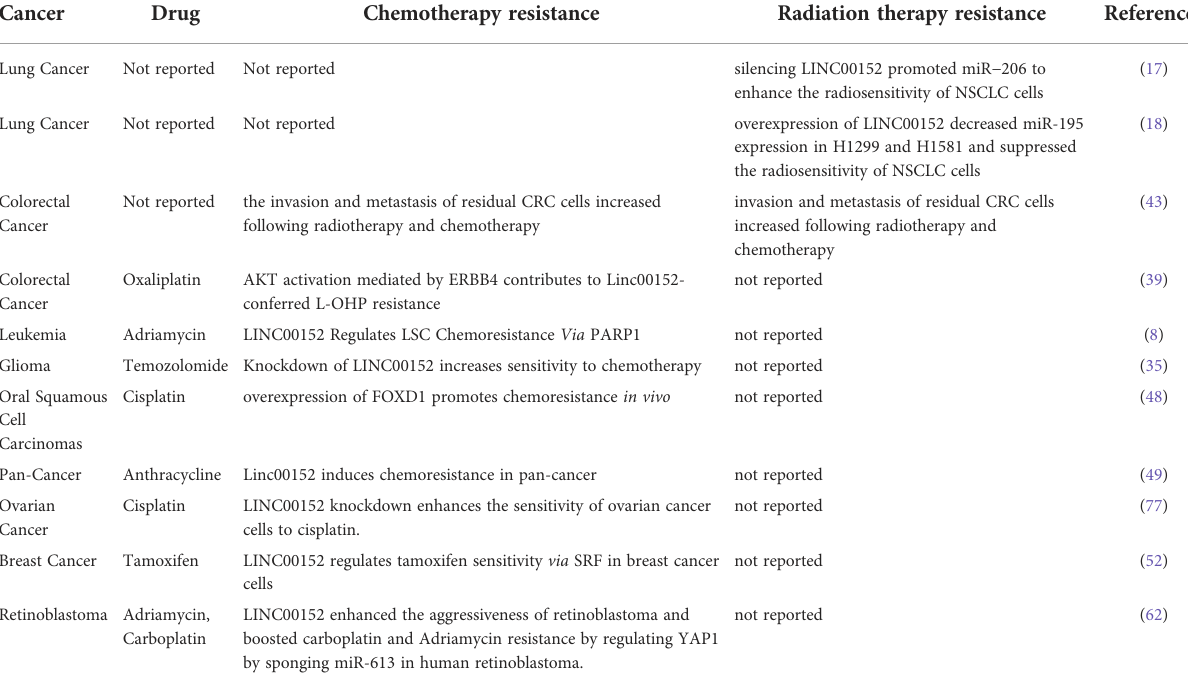
TABLE 3 The role of LINC00152 in chemotherapy and radiation resistance.